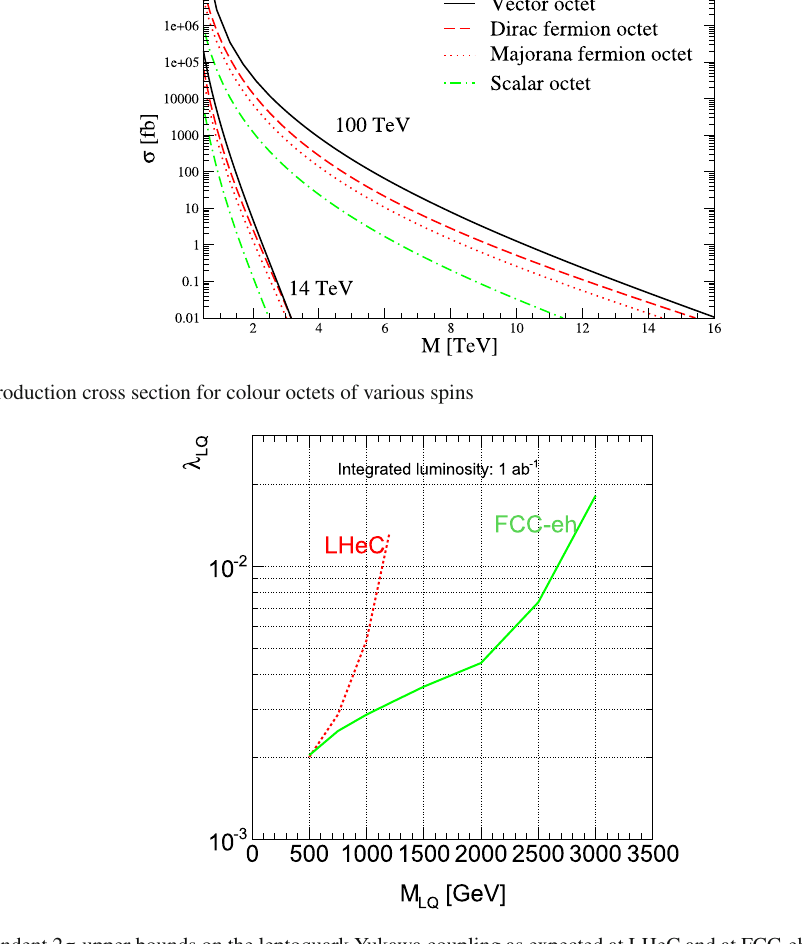
Fig. 15.9 Mass-dependent 2 σ upper bounds on the leptoquark Yukawa coupling as expected at LHeC and at FCC-eh for an integrated luminosity of 1 ab − 1 . An efficiency of 80% is assumed on signal